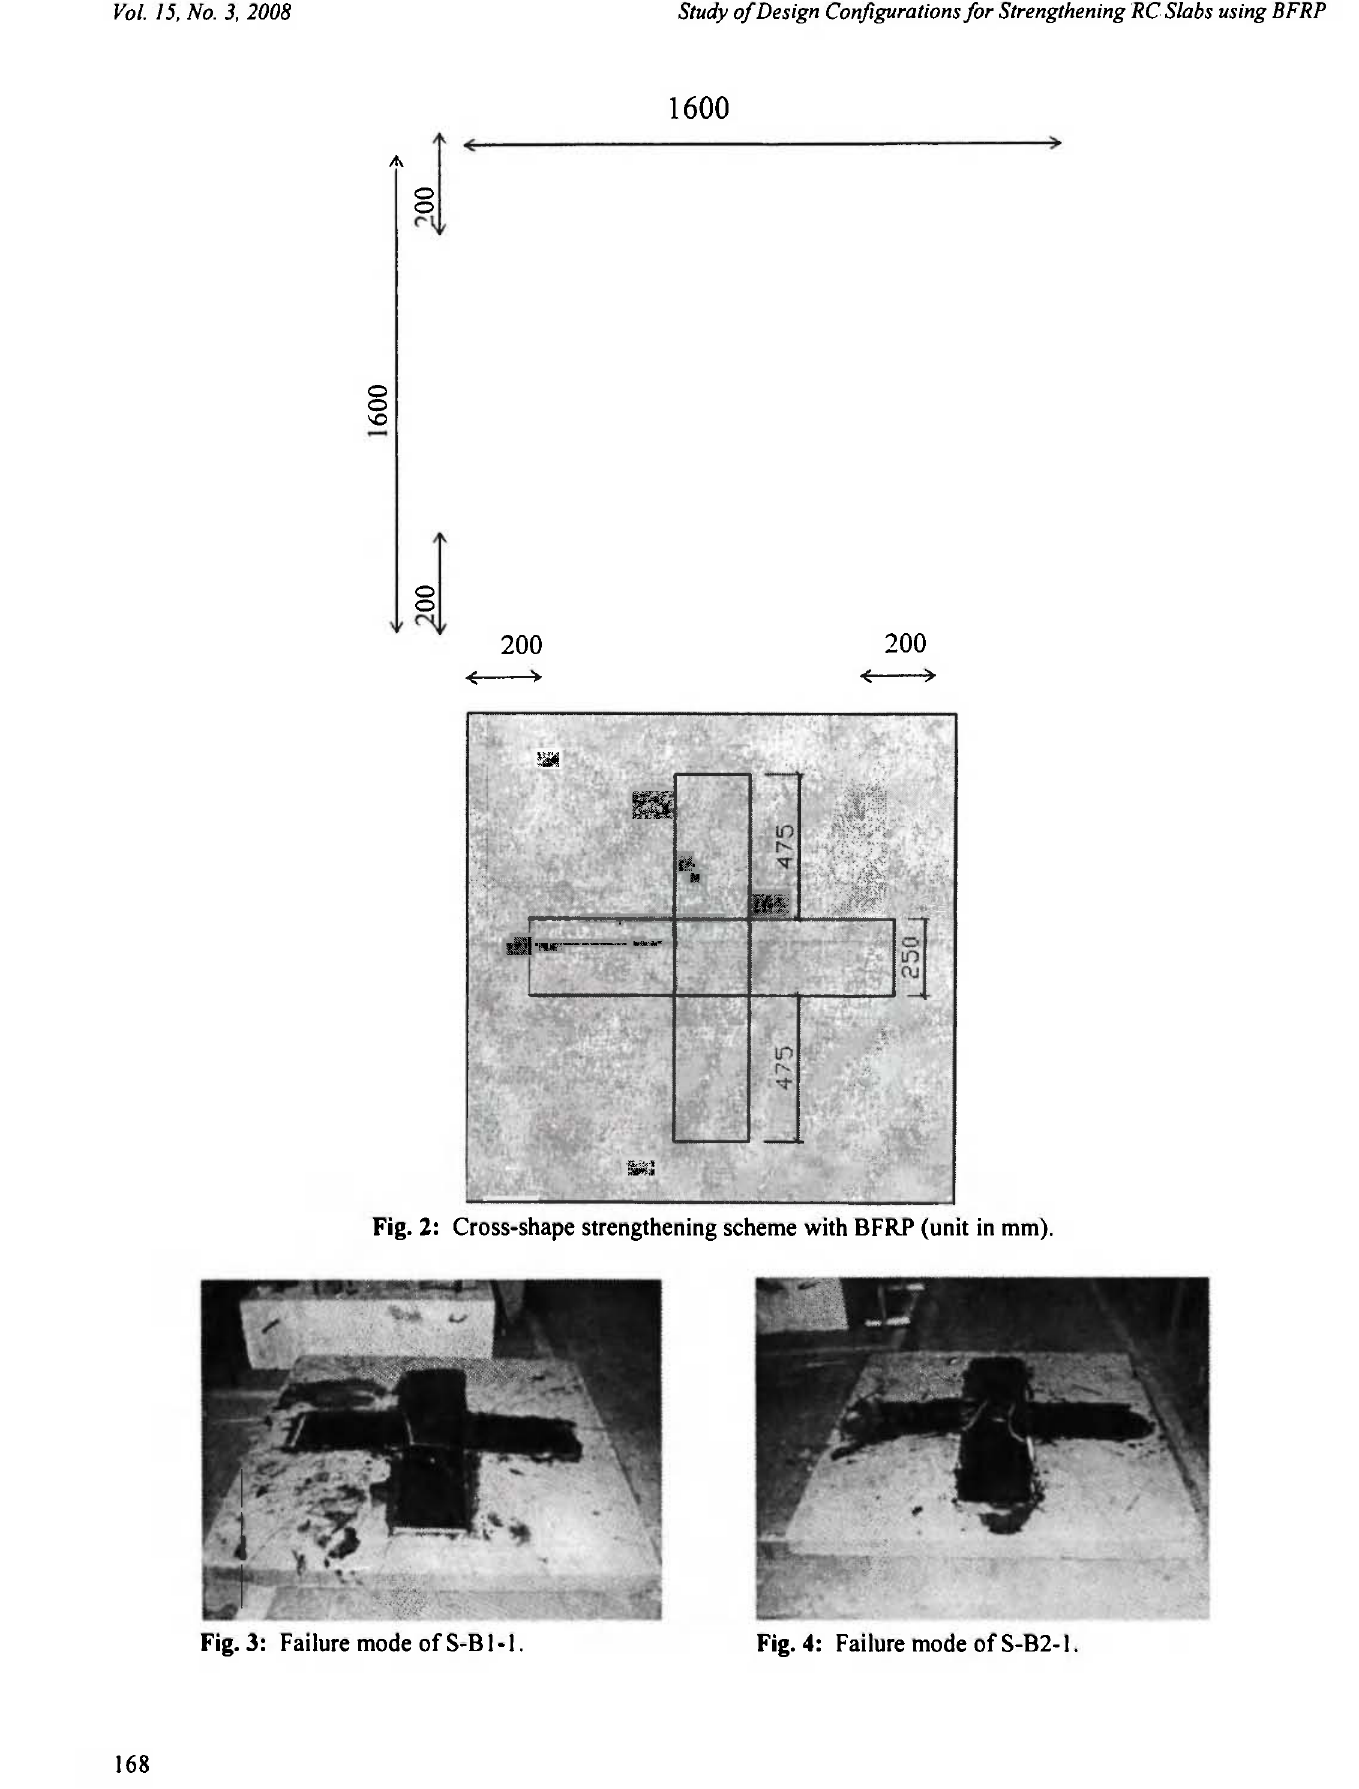
Fig. 2: Cross-shape strengthening scheme with BFRP (unit in mm).